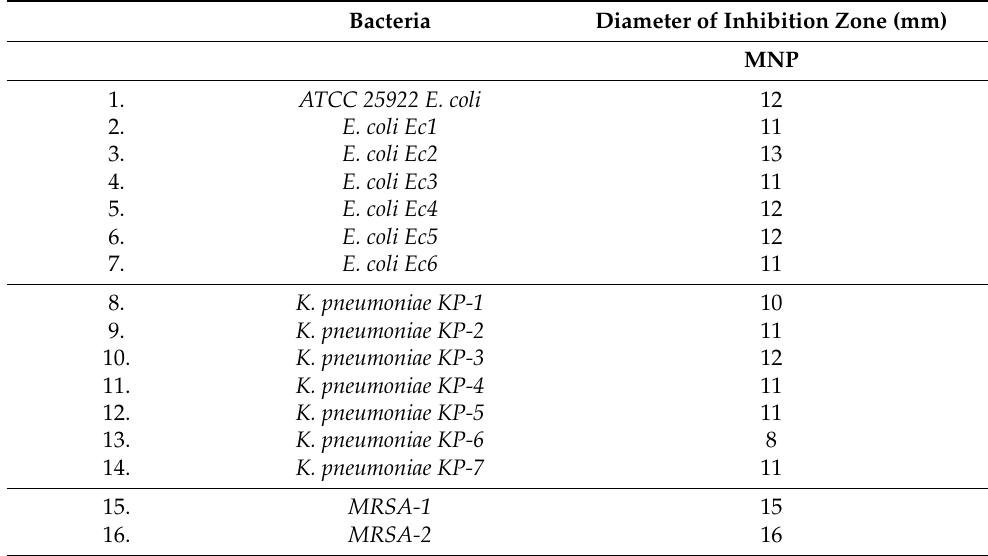
Table 9. Diameter of zone of inhibition (mm) observed for MNP against MDR